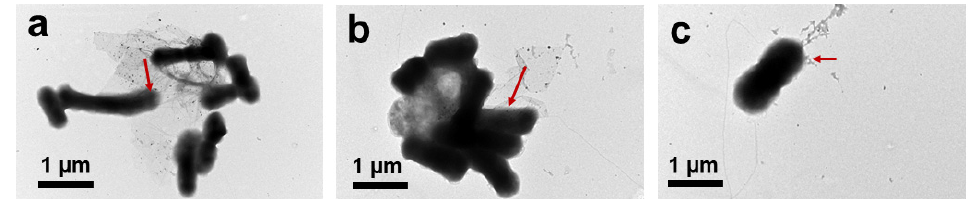
Figure 13. TEM images of E. coli after treatment with >1 µm ( a ), ~1 µm ( b ) and ~100 nm ( c ) GO–Ag NPs for 1 h incubation. Red arrow indicated for silver nanoparticles (Ag NPs) penetration into E. coli.